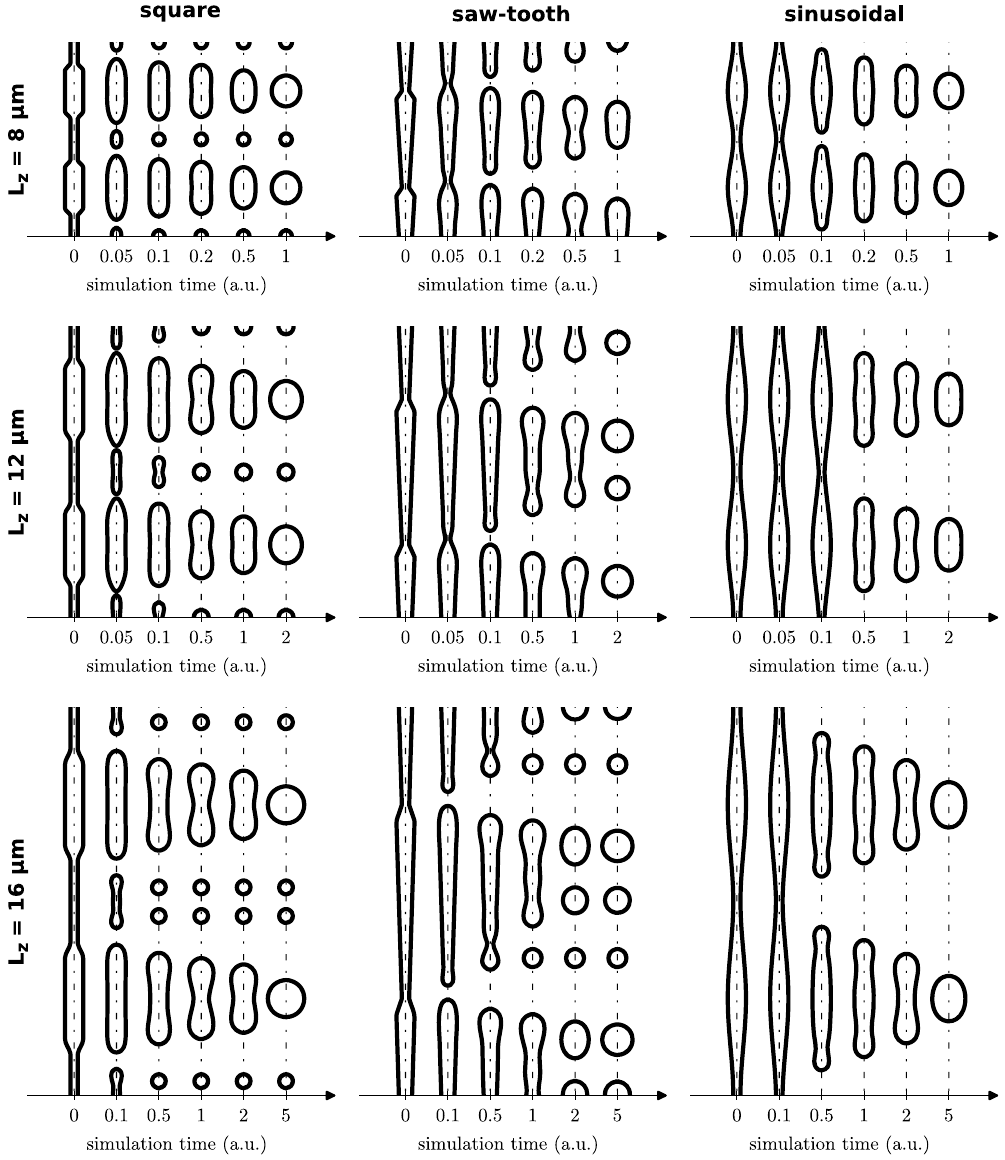
Figure 3. Structural evolution by surface diffusion, snapshot sequences, of infinitely-long modulated pores with different initial pore shape and different in-depth modulation periodicity, L z . For all calculations, d min = 0.5 a and d max = 1.5 a